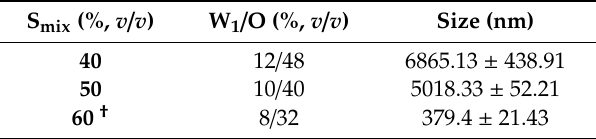
Table 1. E ff ect of S mix ratio ( v / v ) on the size of W 1 / O emulsion (at 25 ◦ C, n = 3, mean ± SD). S mix (%, v / v